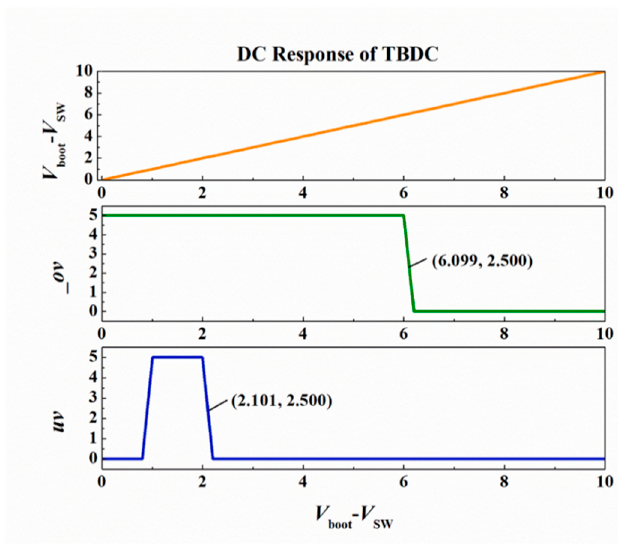
Figure 8. Simulated DC under-voltage and over-voltage threshold of TBDC.